Question: Produce a descriptive caption suitable for publication.
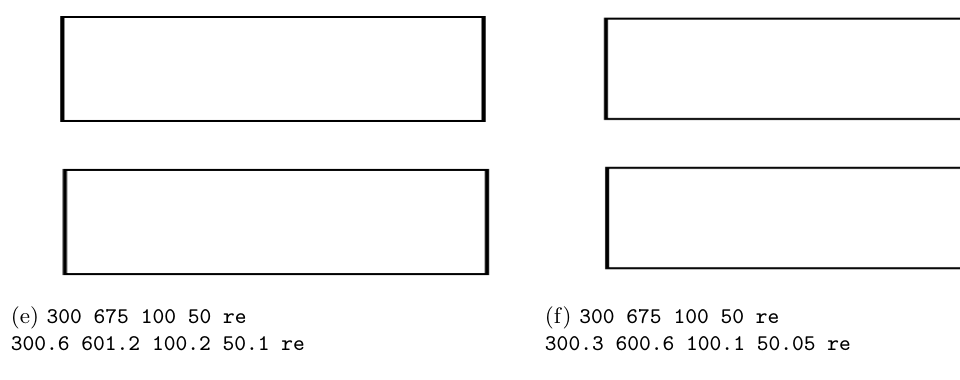
Answer: re Operator - control, 10%, 1%, 0.5%, 0.2% 0.1% (0.2%)